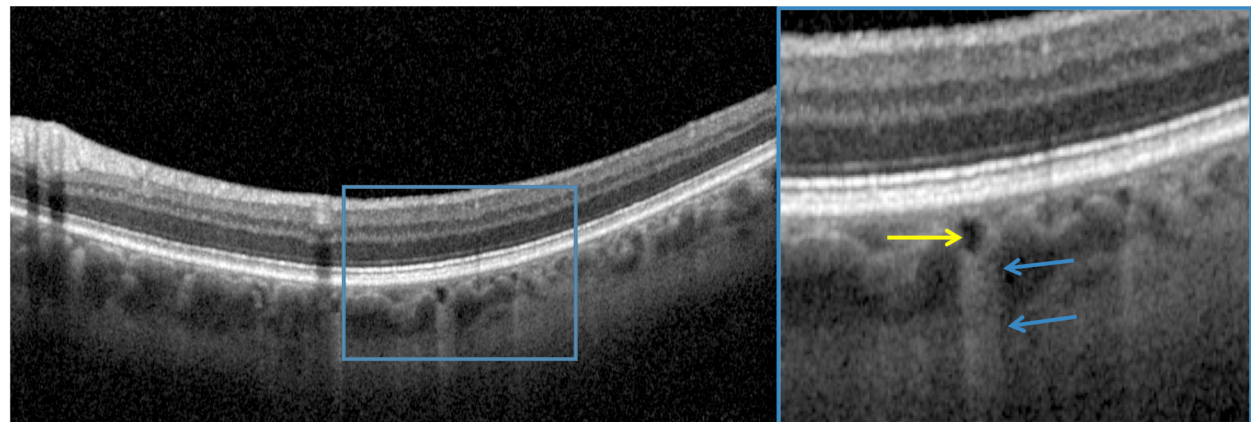
Figure 1. Optical coherence tomography showing a choroidal “cavern” (yellow arrow) defined as a focal area of internal hyporeflectivity with a characteristic hypertransmission signal underneath (blue